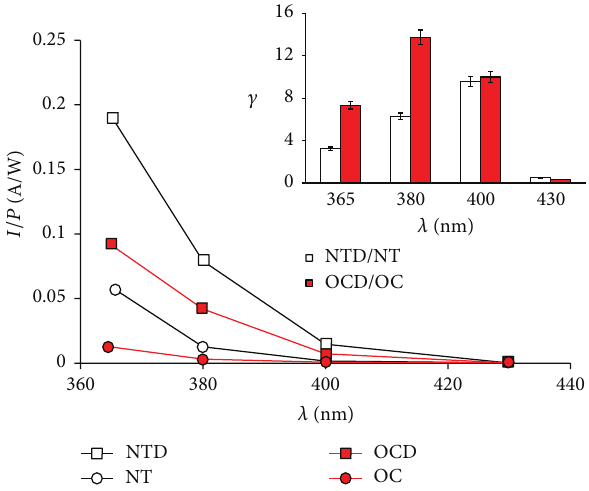
Figure 3: Values of photocurrent, normalized with respect to the power of incident light, obtained at different wavelengths with different samples, during potential steps at 1V from the OCV. The inset shows the performance gain 𝛾 evaluated as ratio between the current values obtained with decorated and not decorated samples ( 𝛾 = 𝐼 𝐷 /𝐼